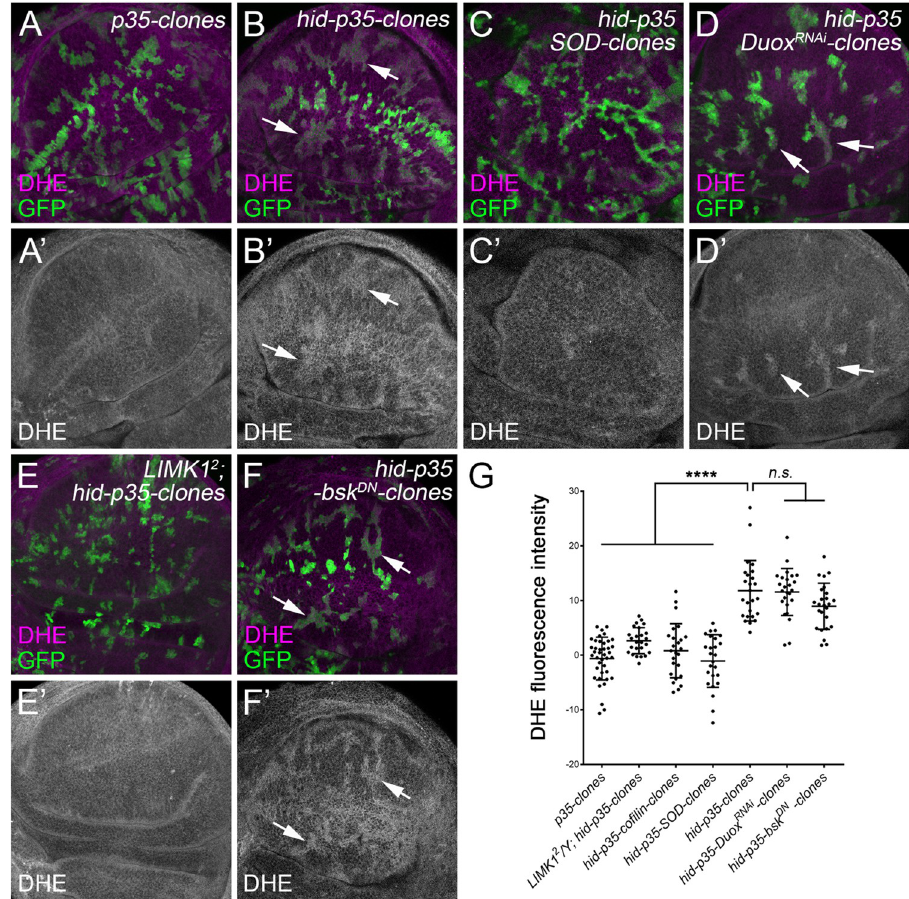
Fig 6. LIMK1 and Cofilin regulate production of cytosolic ROS in hid-p35 clones. (A-F’) Late 3 rd instar wing discs with 48-hour old mosaic clones positively marked by GFP. Dihydroethidium (DHE) staining (magenta in A-F and grey in A’-F’) is used to indicate the level of ROS. Images of the apical side of the discs are shown. Compared to the control clones expressing P35 only (A, A’), simultaneous expression of hid and p35 ( hid-p35 clones) leads to an increased production of ROS in the clones (B, B’, arrows). This increased ROS production is suppressed by expression of SOD, a superoxide dismutase (C, C’). In contrast, RNAi knockdown of Duox, a transmembrane NADPH oxidase, does not obviously affect the level of ROS in hid-p35 clones (D, D’, arrows). Increased ROS production in hid-p35 clones is also inhibited in a LIMK1 2 mutant background (E, E’), but not in response to expression of bsk DN , (F, F’, arrows). (G) Quantification of the DHE signal intensity in the representative clones of the indicated genotypes in the wing disc pouches. Compared to the p35 clones, the DHE signals are significantly ( ���� p < 0.0001) increased in the hid-p35 clones. This increase is significantly ( ���� p < 0.0001) reduced in response to expression of SOD , cofilin or in LIMK1 2 mutants, but not (n.s.) in response to expression of bsk DN or Duox RNAi . Myo1D, an unconventional myosin, has been previously shown to physically interact with Dronc and mediate its role on activation of JNK in AiP [20]. We therefore examined whether Myo1D mediates the interaction between Dronc and LIMK1. RNAi knockdown of Myo1D completely suppresses the phenotypes of F-actin accumulation, JNK activation and tissue over- growth induced by co-expression of Dronc and LIMK1 (Fig 7D–7D”). Consistent with this, expression of Dronc or LIMK1 alone results in adult heads with moderate overgrowth pheno- types, including duplicated ocelli and bristles (Fig 7E and 7F). In contrast, co-expression of Dronc and LIMK1 causes semi-lethality with escapers showing severe adult head overgrowth phenotype (Fig 7G). This overgrowth phenotype is completely suppressed by knockdown of